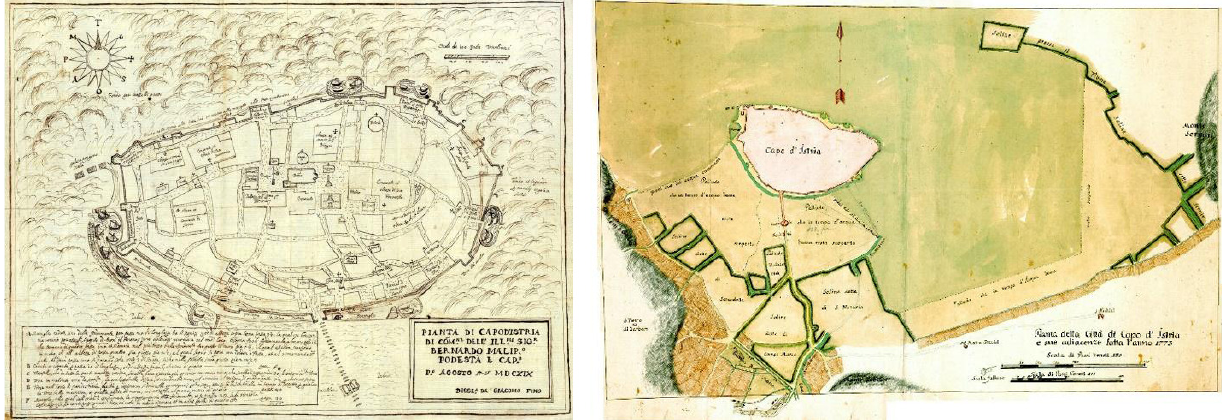
Figure 3. The island of Koper in 1619 and 1773. (a) Island of Koper in 1619 by Giordano Fino (left); (b) Island of Koper in 1773 by unknown author (right). Sources: Krmac (2009) and Archivio di Stato di Trieste